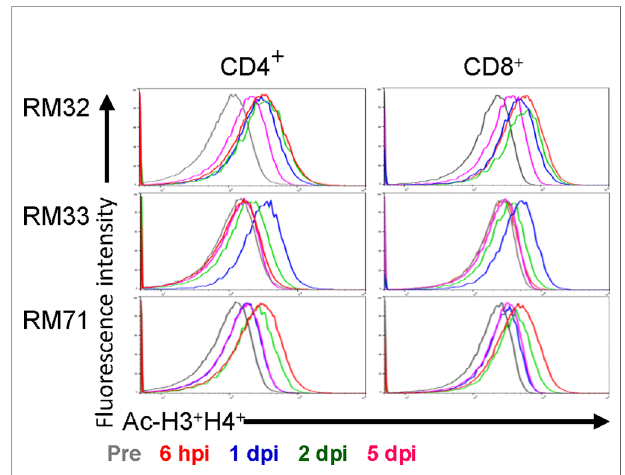
FIGURE 3 | Histone acetylation of peripheral CD4 + and CD8 + T cells with RMD treatment. The levels of histone acetylation (H3 and H4) were measured in peripheral CD4 + and CD8 + T cells by fl ow cytometry prior to RMD treatment, at 6 hpi, 1, 2, and 5